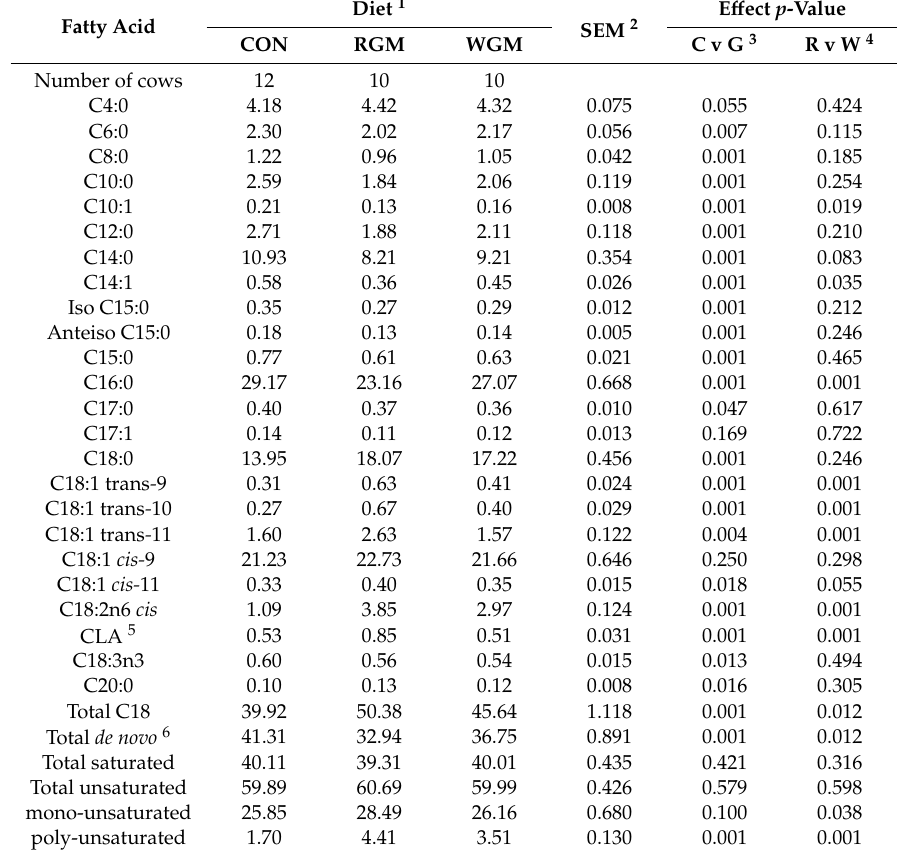
Table 6. Fatty acid composition of milk fat (g / 100 g of fatty acid) from cows fed a control diet, a diet containing red grape marc or a diet containing white grape marc.